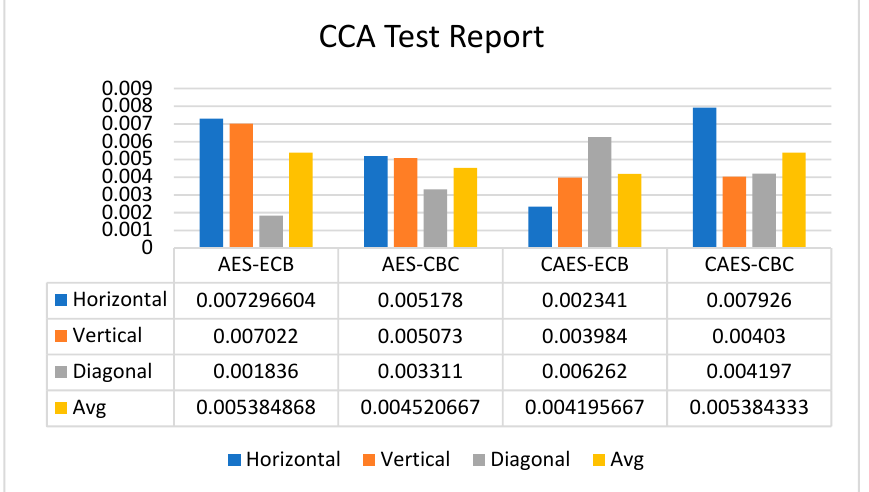
Figure 14. Test report of the connected component analysis.